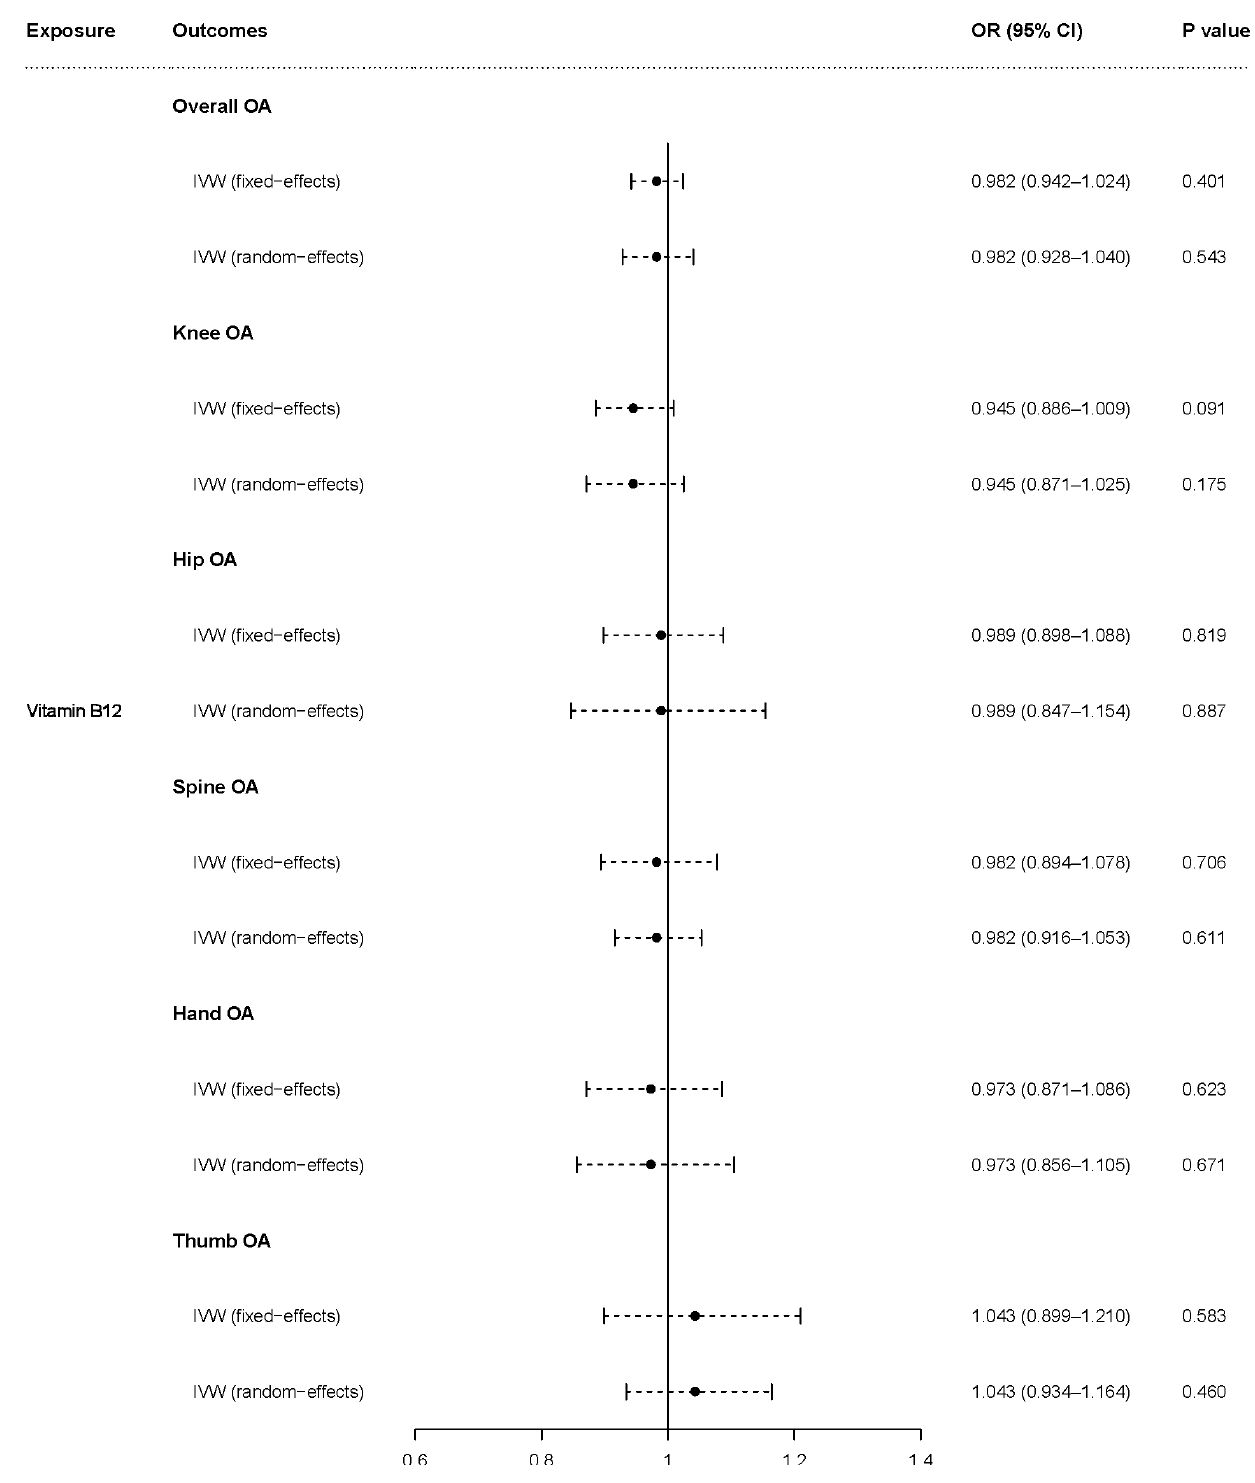
Figure 4. Causal effect of vitamin B12 on OA and subtypes in fixed-effects and random-effects IVW analyses. OR: odds ratio; CI: confidence interval; p value: p value of the causal estimate.